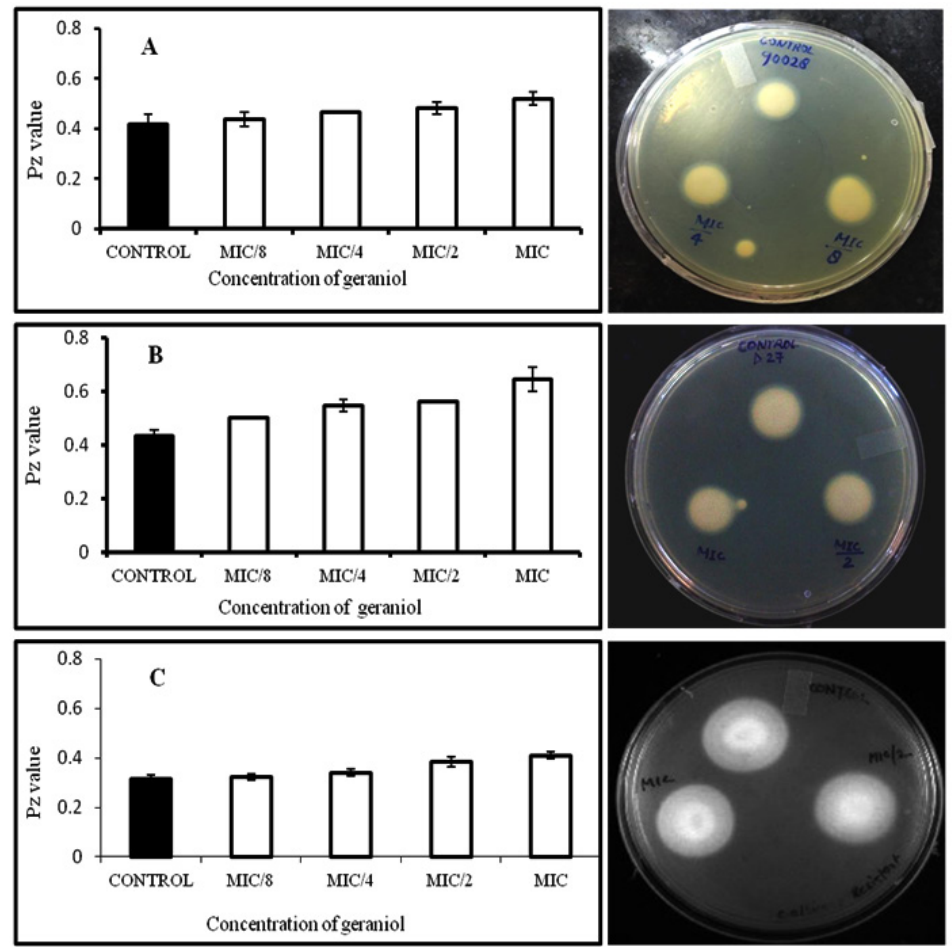
Fig. 5. Effect of geraniol on phospholipase secretion in C. albicans ATCC 90028 (A), C. albicans D-27 (B), C. albicans S-1 (C) in the presence of different concentrations of geraniol (1/8 MIC, 1/4 MIC, 1/2 MIC and MIC)